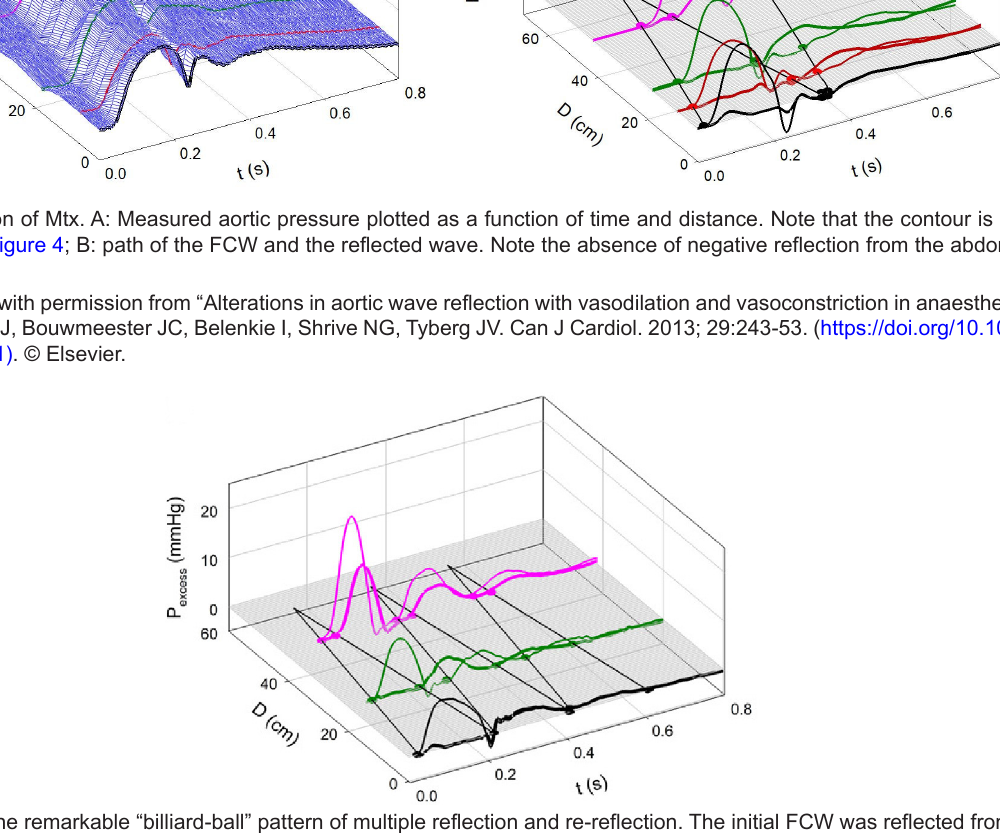
Figure 8. Note the remarkable “billiard-ball” pattern of multiple reflection and re-reflection. The initial FCW was reflected from the periphery, re-reflected from the closed aortic valve, re-re-reflected from the periphery, again re-re-re-reflected from the closed aortic valve, and re-re-re-reflected to cause a BCW above the aortic bifurcation. With Mtx, aortic stiffness and wave speed were increased [7] Note. Reprinted with permission from “Alterations in aortic wave reflection with vasodilation and vasoconstriction in anaesthetized cjca.2012.03.001). ©